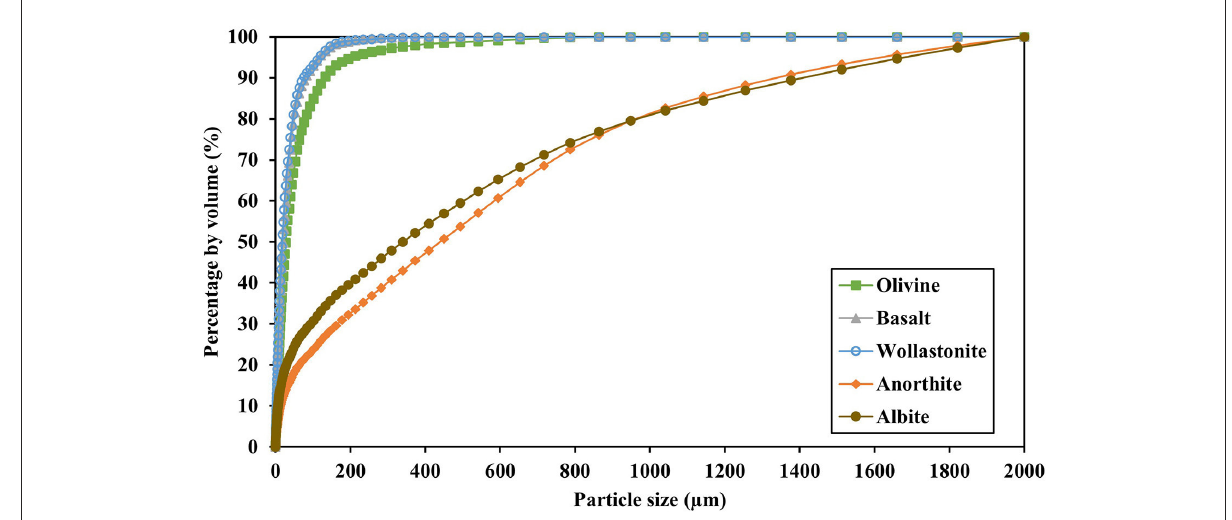
FIGURE1 Particle size distribution of the five silicates used in this experiment, measured by laser diffraction ( n =